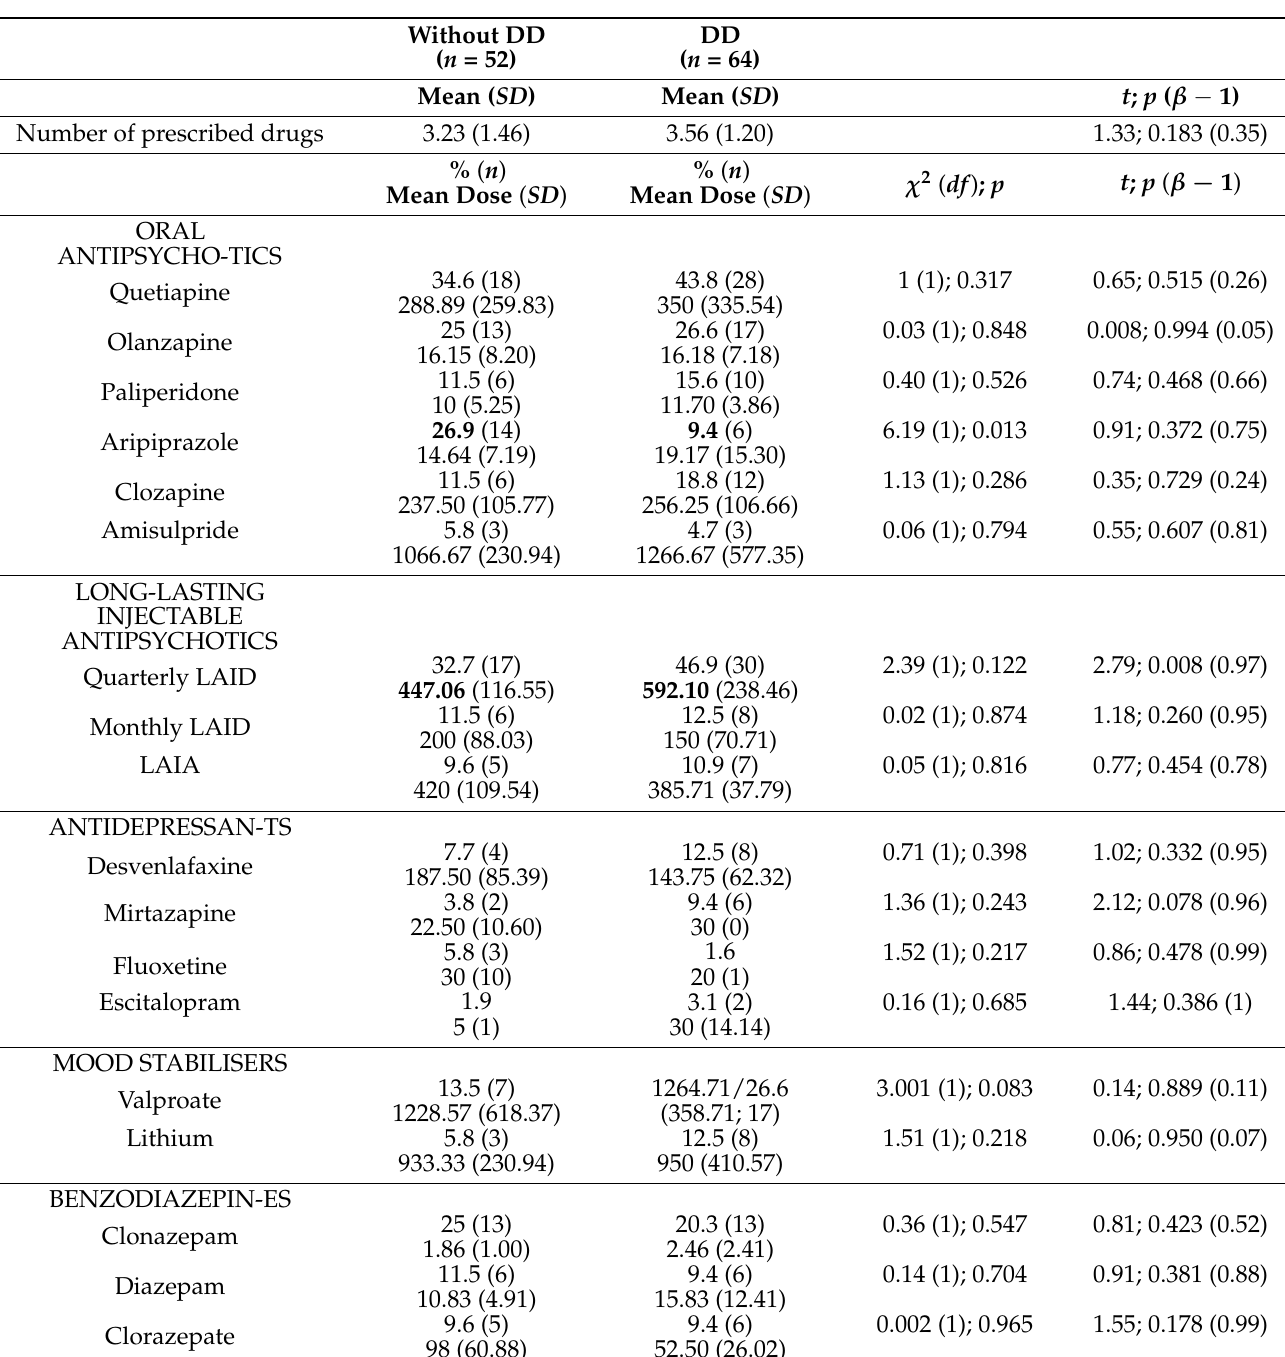
Table 3. Differences in the dosage and number of psychotropic drugs used at Medium-Stay Unit